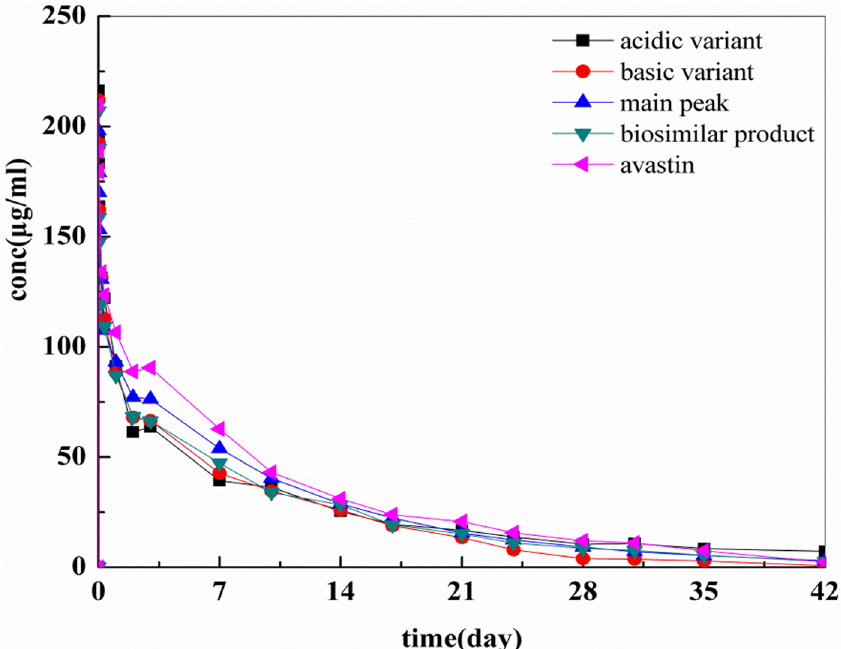
Fig 5. Concentration-time profiles of the isolated charge variants, the biosimilar product and Avastin. The results are shown as the mean ± standard deviation (n = 4 rats/time point).